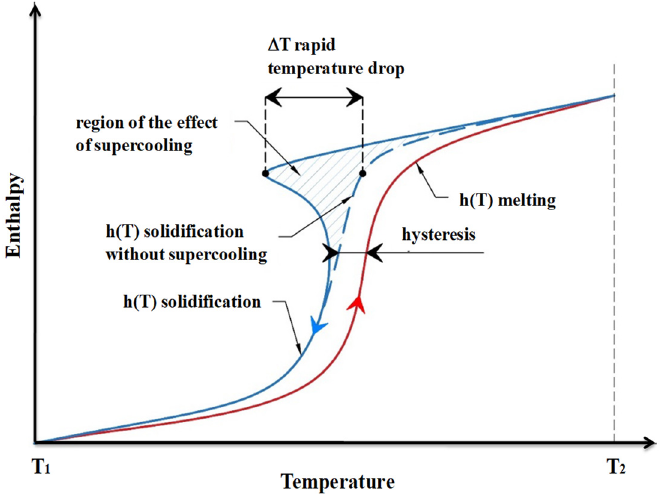
Figure 9. The supercooling phenomenon, reprinted/adapted with permission from Ref. [72], 2022, Elsevier.